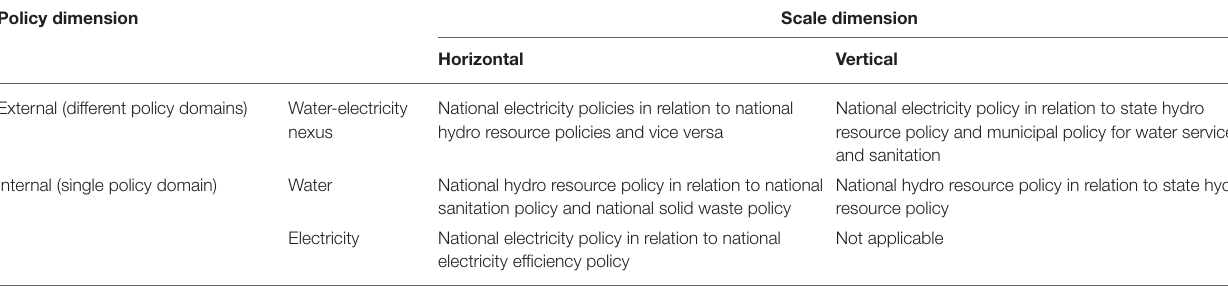
TABLE 2 | Framework for assessment of water and electricity policy asymmetries.